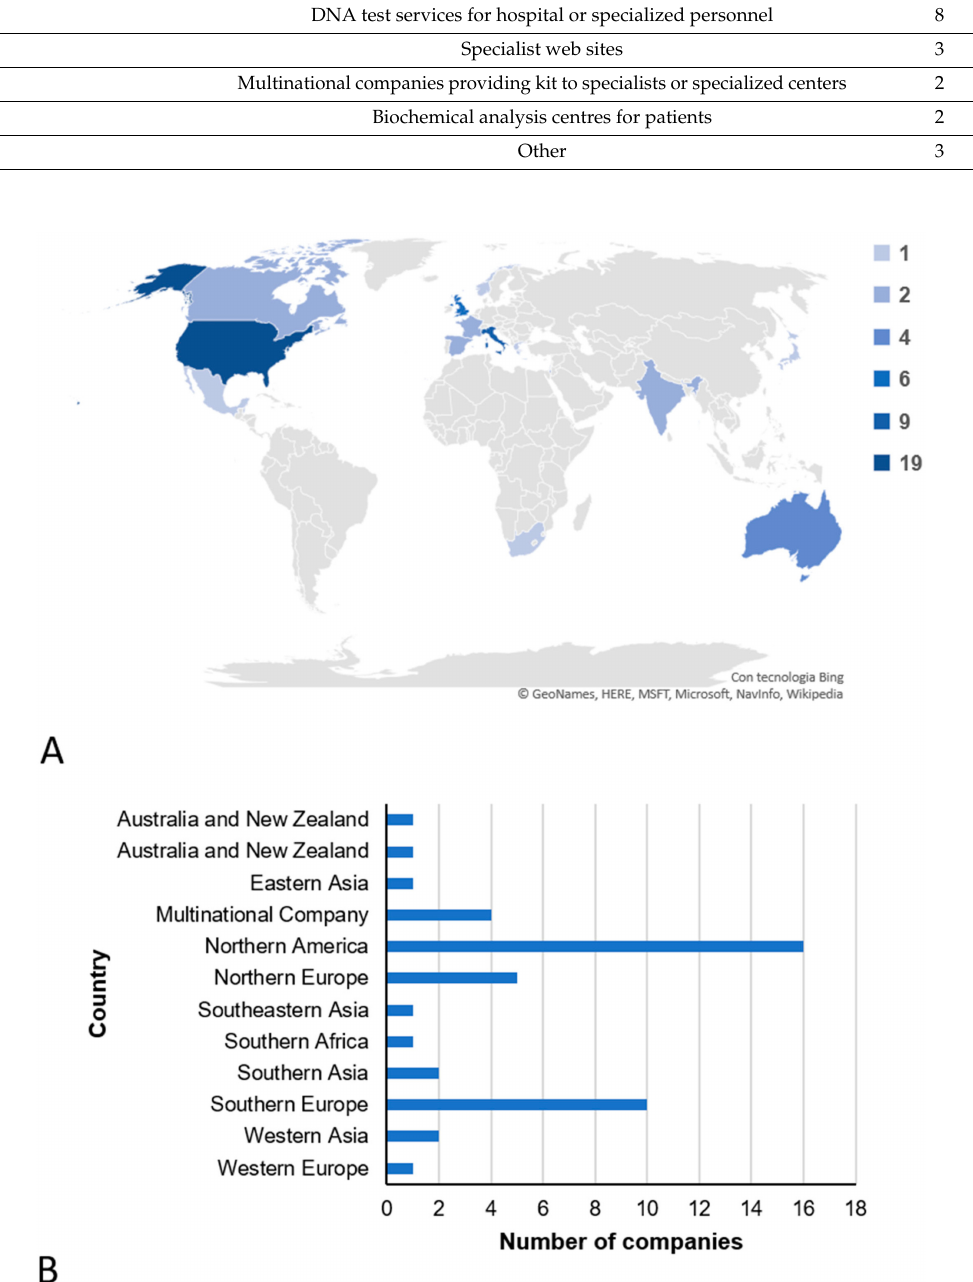
Figure 1. Geographical distribution of the selected nutrigenetics direct-to-consumer genetic testing (DTC-GT) companies. The legend reports the number of DTC-GT companies located in the represented countries ( A ). In graph ( B ), sub-continental classification of the 45 selected DTC-GT companies is shown. Multinational companies’ headquarters are located in several countries. N.A. = information not